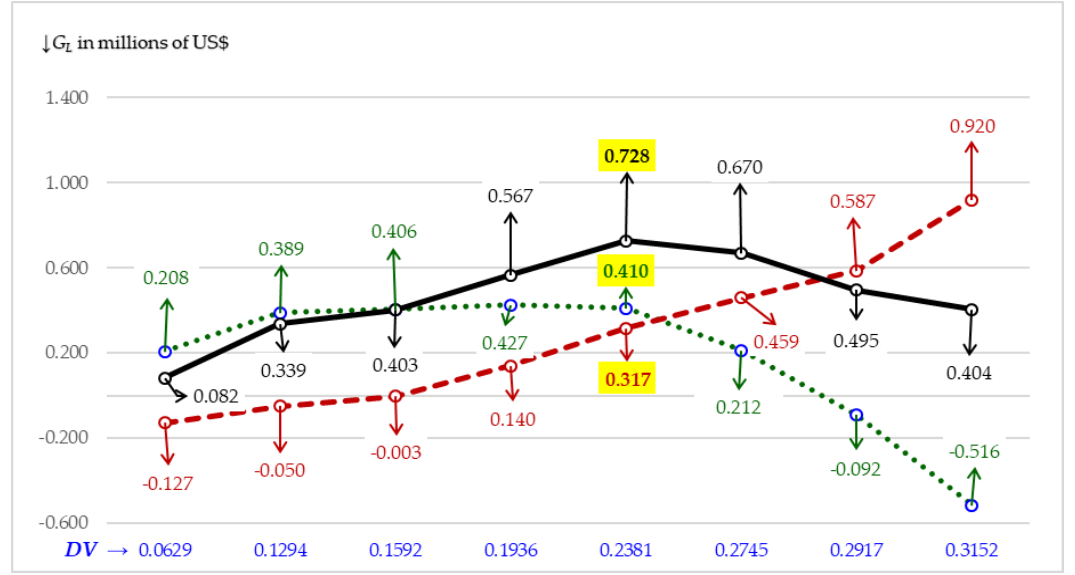
Figure 2. Growth Pass-Through G L Versus DV under TCJA with g L of 3.12% and OCR of A3. Gain to Leverage ( G L ), solid line; 1st Component, dotted line, and 2nd Component, dashed line.